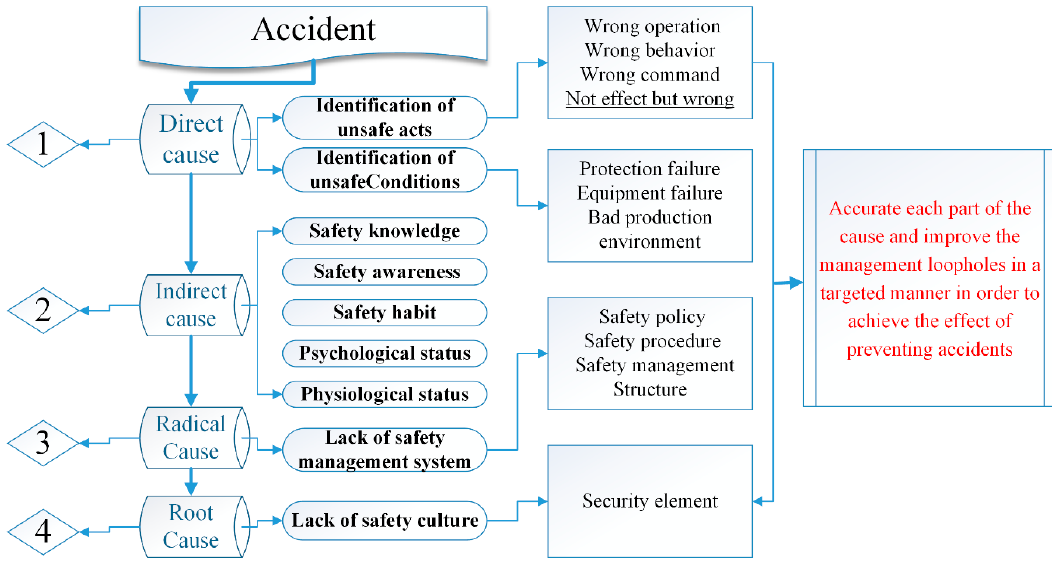
Figure 9 . Accident causes analysis flow chart. Figure 9. Accident causes analysis flow